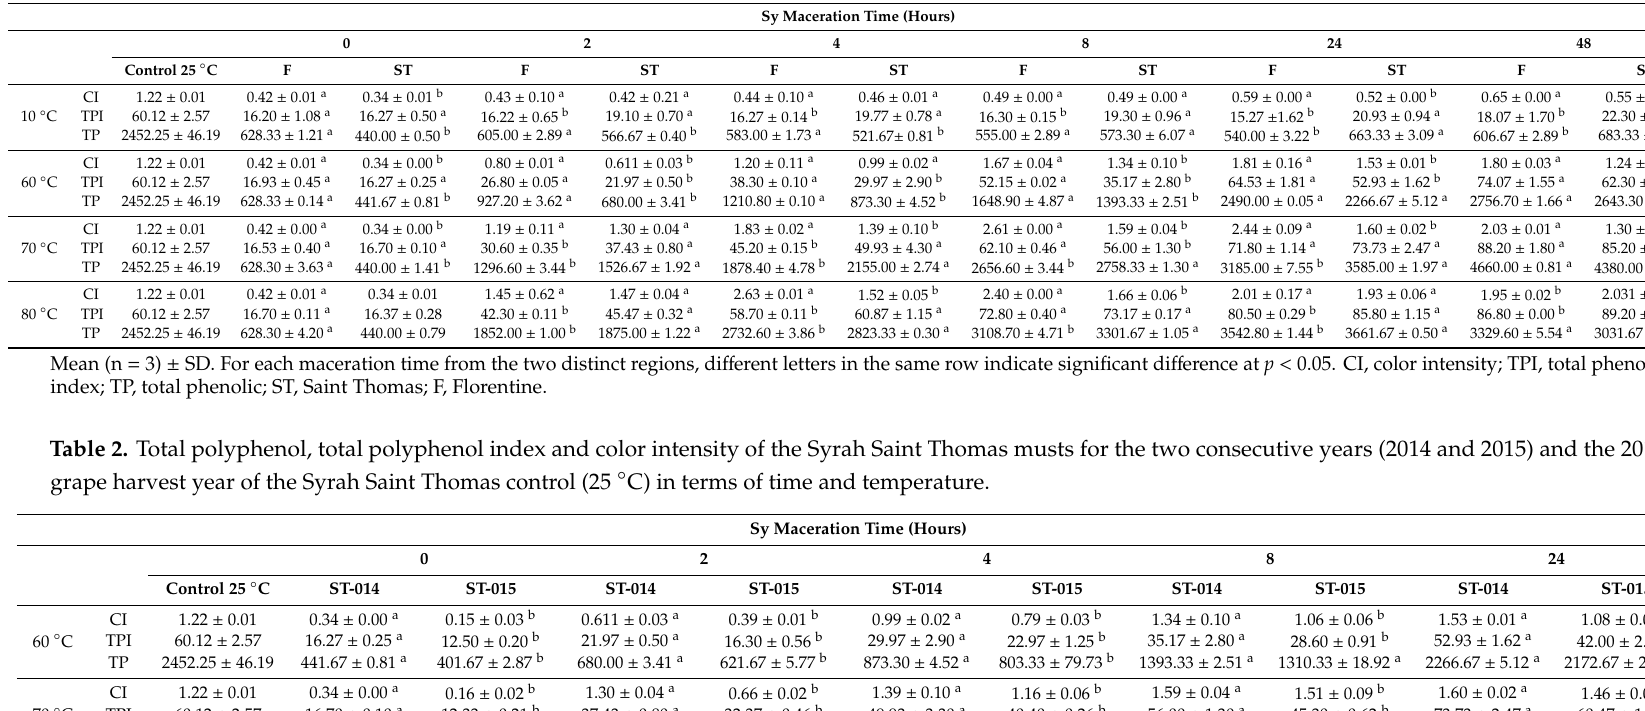
Table 1. Total polyphenol, total polyphenol index and color intensity of the 2014 Syrah Saint Thomas and Syrah Florentine musts and the 2014 grape harvest year of the Syrah Saint Thomas control in terms of time and temperature.